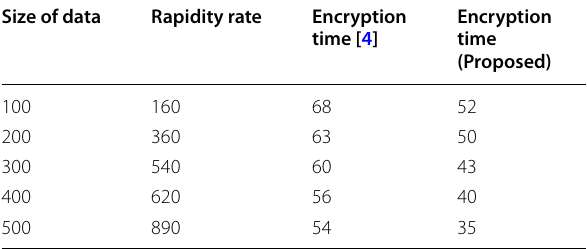
Table 5 Time period of encryption Size of